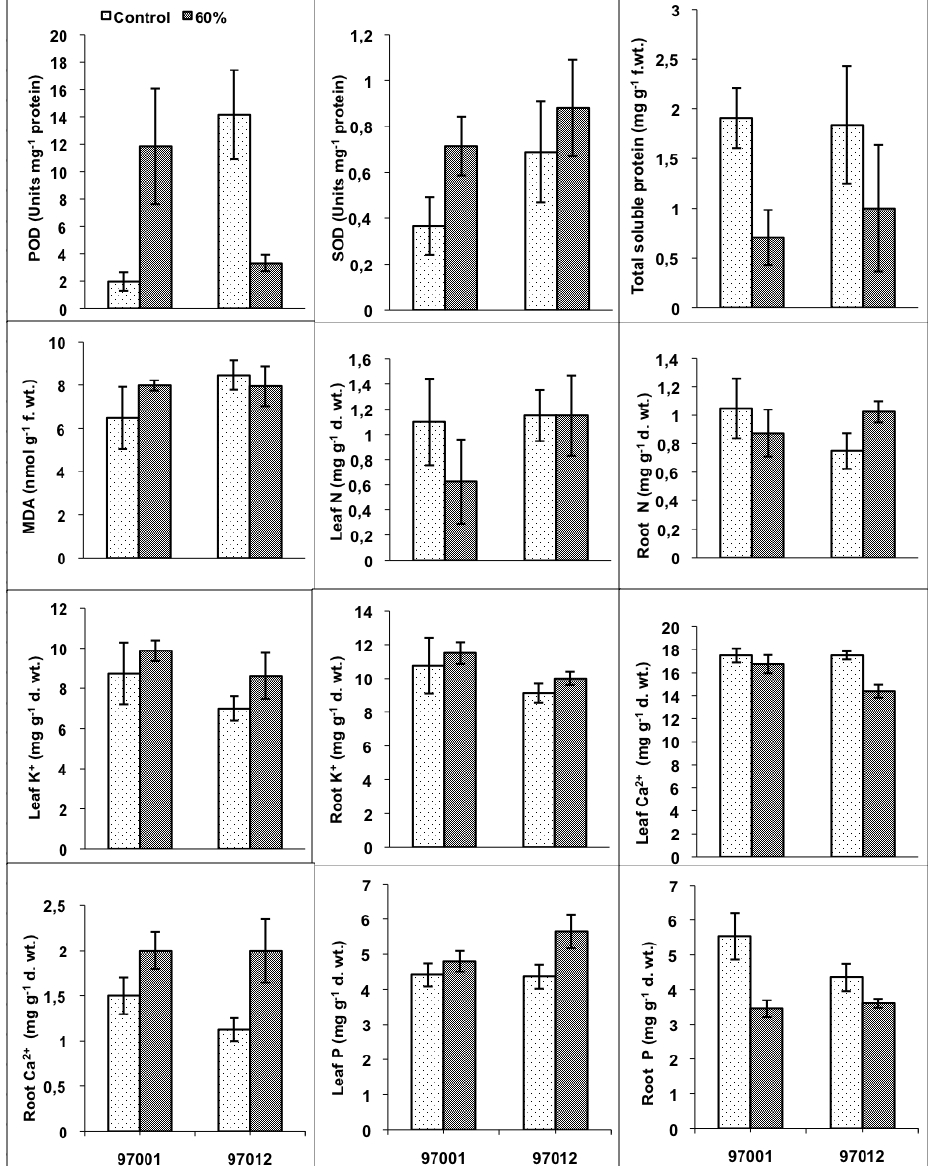
Fig. 3: Activities of antioxidants and mineral nutrients of mungbean [ Vigna radiata (L.) Wilczek] when 30 day old plants were subjected to drought stress (Mean ± S.E.; n = 4). plants. For example, imposition of water deficit stress reduced the water potential and osmotic potential of plants of melon (K US- VURAN , 2012), wild jujube (M ARAGHNI et al., 2011), and common bean (G ULER et al., 2011; Z ALVET et al., 2005). But in the present study, leaf water potential and osmotic potential did not change sig- nificantly by imposition of drought stress while leaf turgor potential increased significantly in mungbean plants due to drought